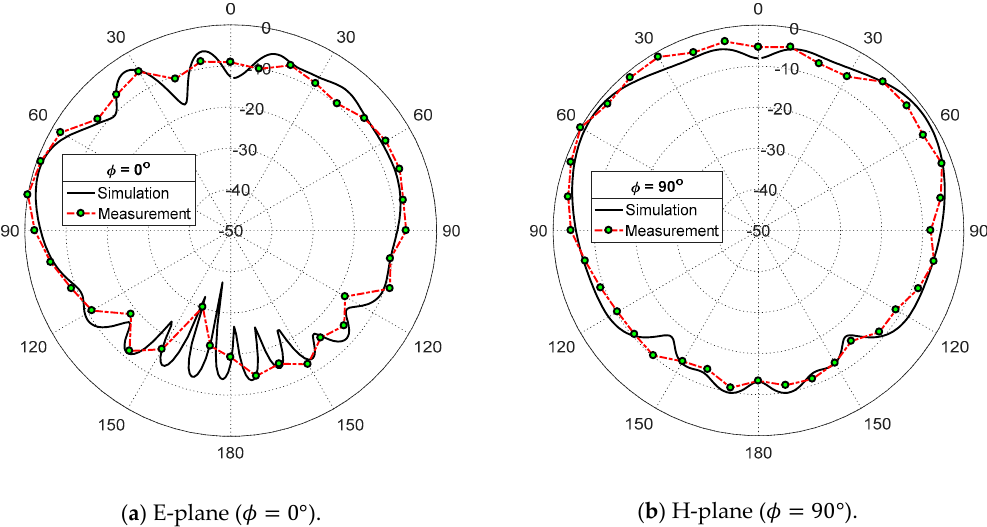
Figure 18. Measured radiation patterns of the proposed dual-band microstrip patch antenna at 60 GHz compared with the simulation results.